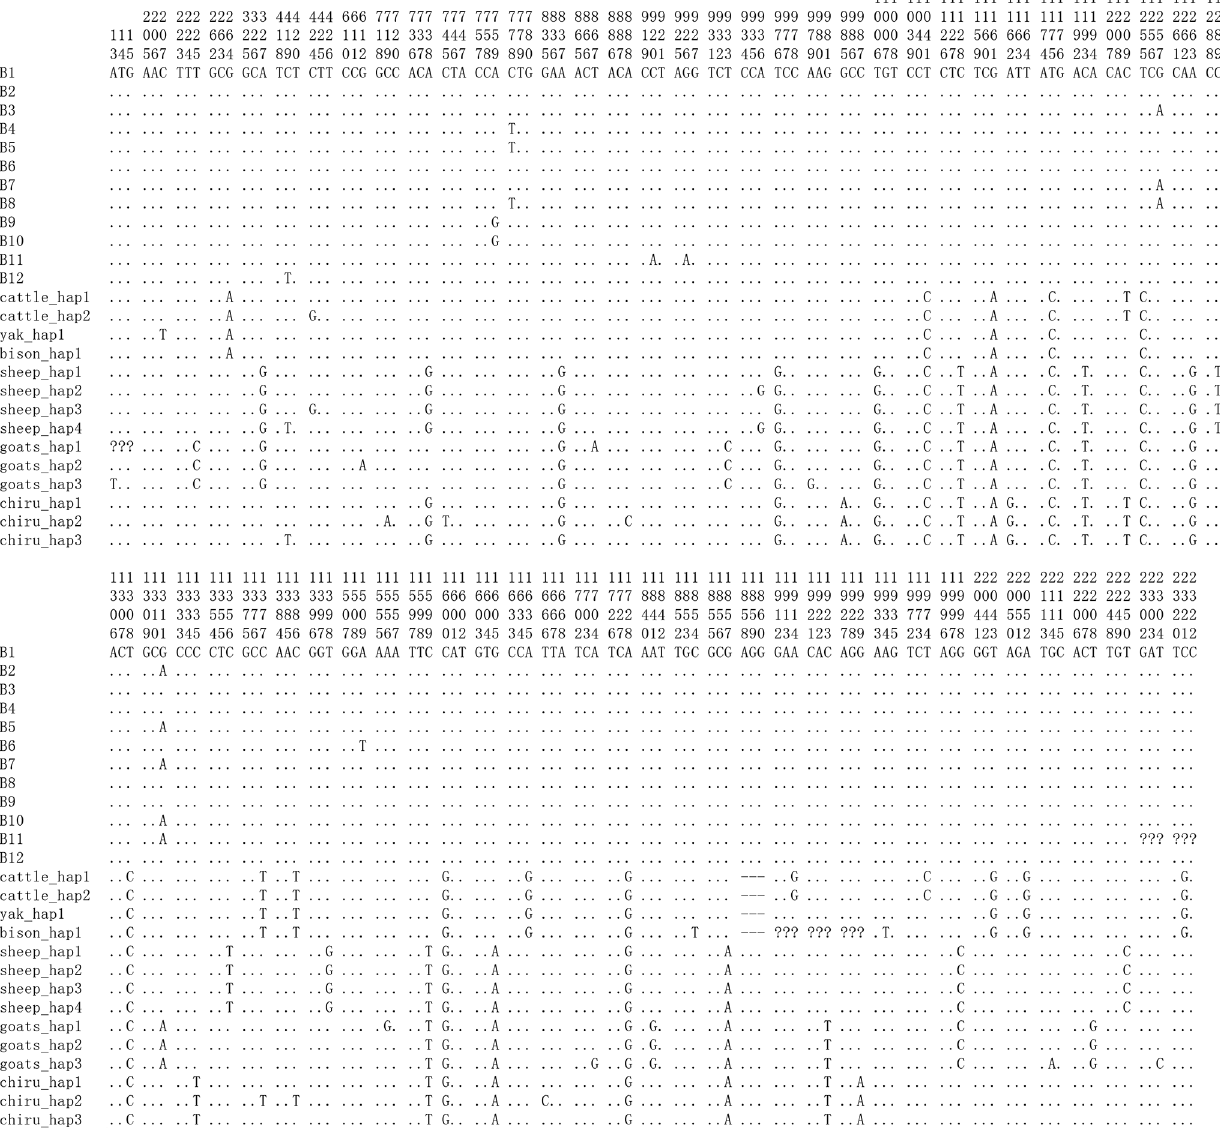
Figure 5. Nucleotide differences of the haplotype sequences among some species of Bovidae. Number represents the position of coding region. Dots (.) denote identity with the B1. Nucleotide substitutions are denoted by different letters. Missing information is denoted by a question mark (?). Horizontal line (–) represents the deletion in the sequences. These definitions apply to the following figure as well.